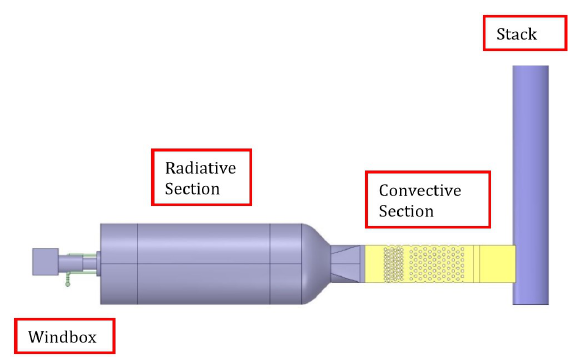
Figure 7. OTSG geometry model for Fireside.